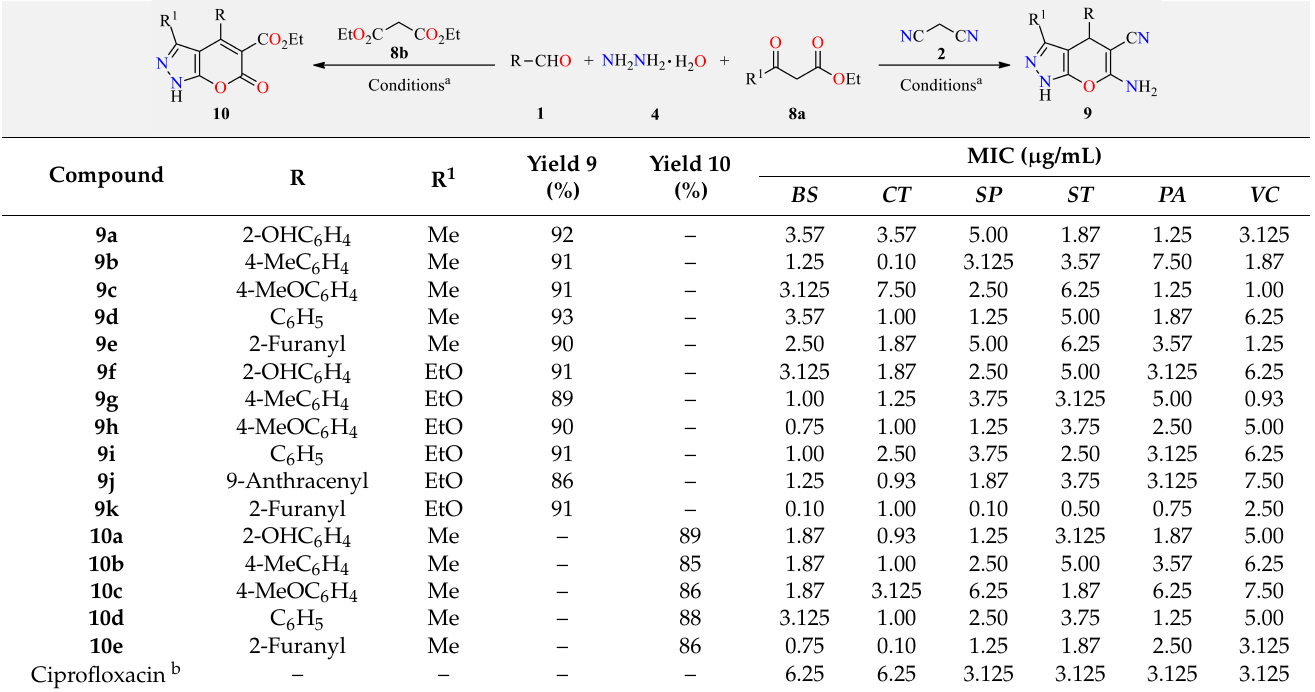
Table 1. Four-component synthesis and antimicrobial evaluation of pyrano[2,3- c ]pyrazole derivatives 9 and 10